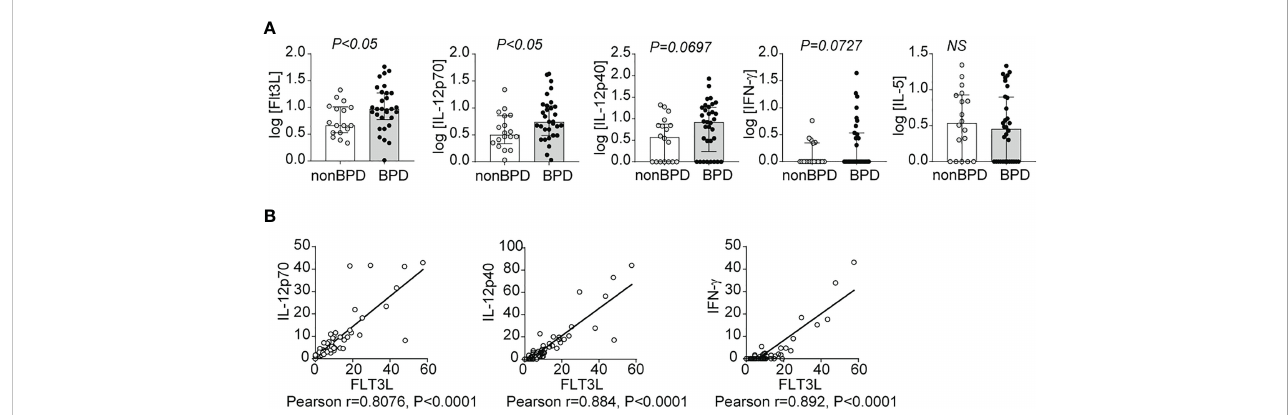
FIGURE 7 In fl ammatory cytokines IL-12p40, IL-12p70 and IFN- g as well as Flt3L are increased in tracheal aspirates of premature infants with respiratory distress who go on to develop BPD. Mechanically-ventilated premature infants with respiratory distress were recruited to the study. Tracheal aspirates were collected during the fi rst week of life. Multiplex ELISA was performed to measure proin fl ammatory cytokine IL-12p40, IL-12p70, IFN- g and IL-5 along with Flt3L protein levels. The cytokine data were log transformed to reduce skewness. BPD was diagnosed based on the requirement for supplemental oxygen or positive pressure ventilation at 36 weeks postmenstrual age. Each protein was compared between infants who went on to develop BPD and those who did not (A) . *P<0.05, unpaired t -test, NS, non-signi fi cant. The association between Flt3L with IL-12p70, IL-12p40, or IFN- g levels was determined by Pearson ’ s correlation analysis (B)